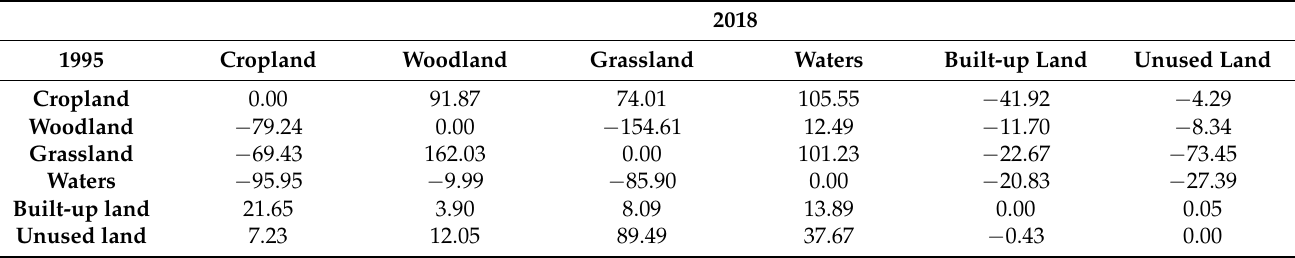
Table 7. Land use ecological benefit change caused by land use change (hundred million